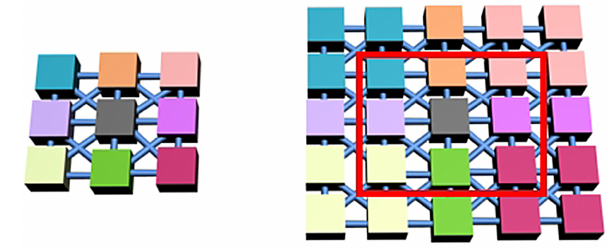
Figure 18. Illustration of eight-connected linked list composed of